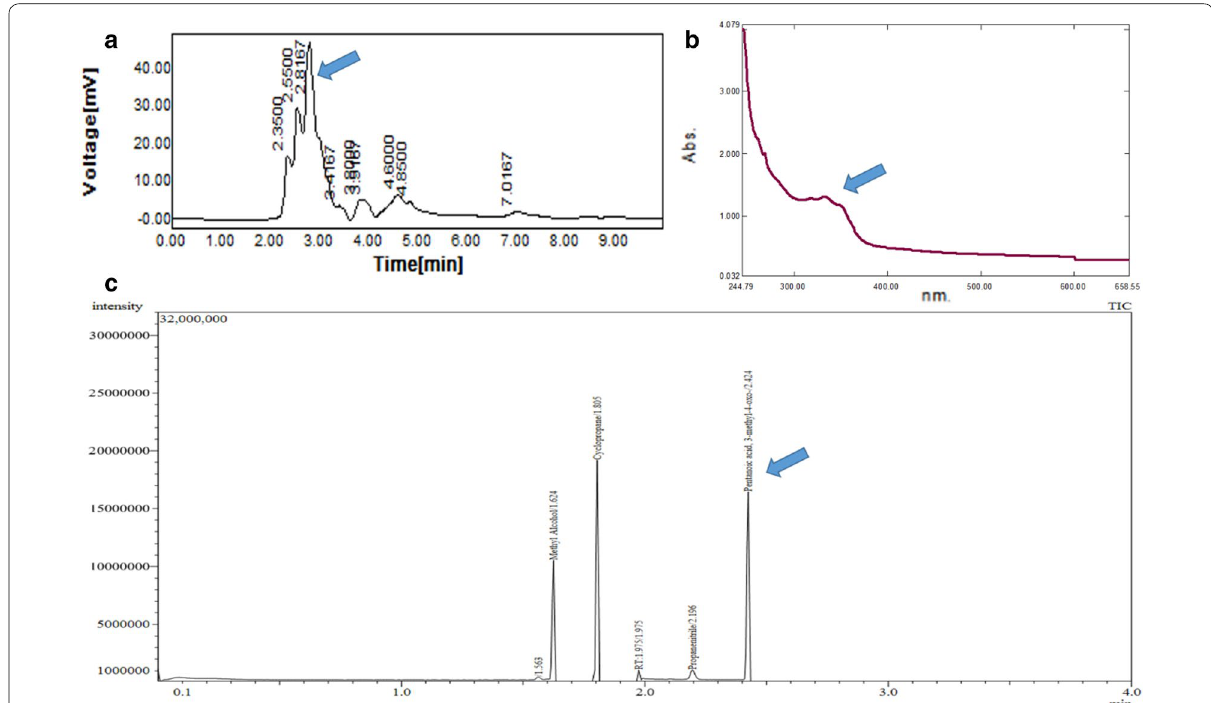
Fig. 1 Spectroscopic analysis of the purified compounds. a Purification of secondary metabolites by using HPLC. b Structural elucidation performed by UV–visible spectrophotometry. c . Depicted graph is GC–MS analysis of natural products of Talaromyces purpureogenus isolate-